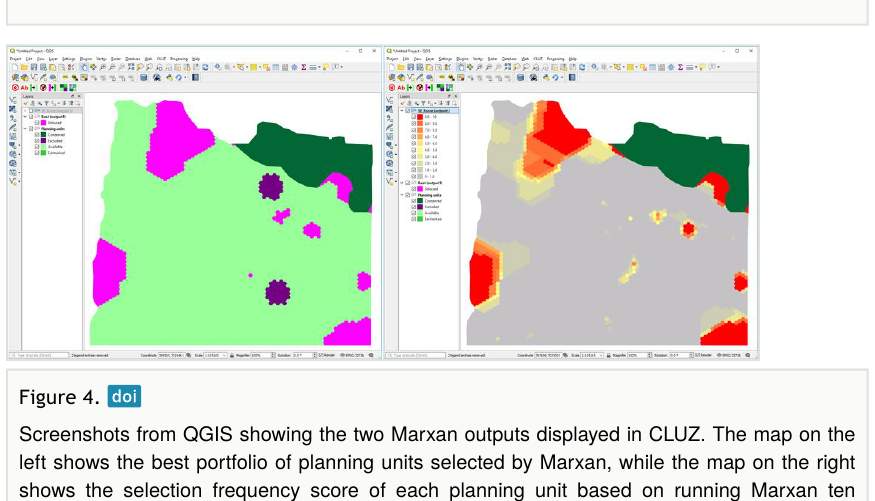
Screenshots from QGIS showing the two Marxan outputs displayed in CLUZ. The map on the left shows the best portfolio of planning units selected by Marxan, while the map on the right shows the selection frequency score of each planning unit based on running Marxan ten times, with planning units in red being selected in every one of the ten Marxan